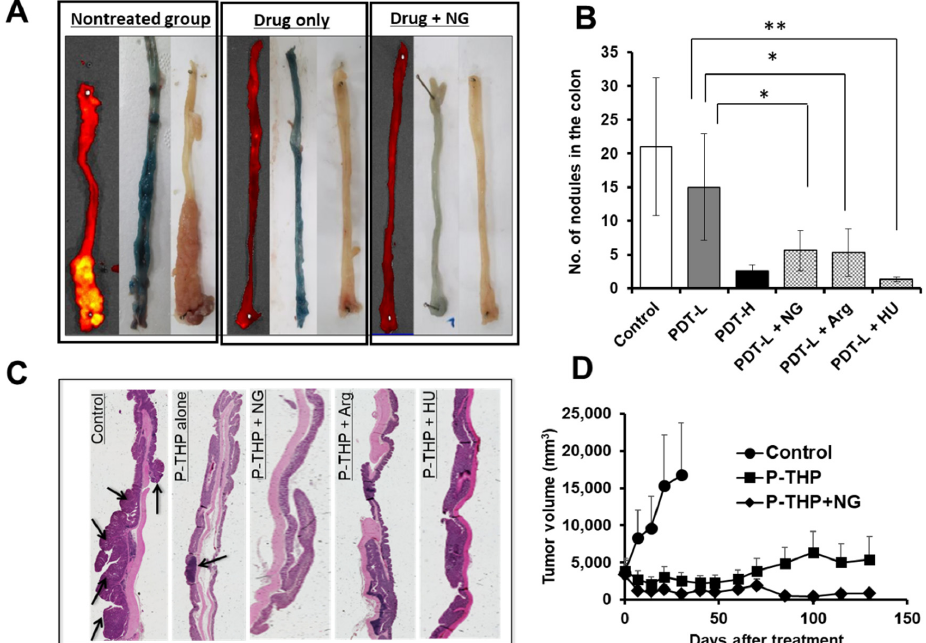
Figure 4. Improvements in therapeutic effects of nanomedicines by using NO donors in chemically induced tumors. Autochthonous colon tumor was developed by administering the chemical azoxymethane (AOM, 10 mg/kg, intraperitoneally) followed by 1 week of drinking 2% dextran sodium sulfate (DSS). At 8–10 weeks after AOM injection, tumor nodules that appeared in the colon were confirmed by examining 2 or 3 randomly killed mice. P-THP at 15 mg/kg iv was infused with NG, and tumor nodules in the colon were visualized by using bovine serum albumin conjugated with rhodamine or Evans blue after 30–40 days of P-THP treatment ( A ). Another nanomedicine, PZP, which was used with light irradiation (PDT) and EPR effect enhancers, produced a similarly improved therapeutic effect ( B ). Enhancement of the anti-cancer effect with NO donors in colon tumors was confirmed by means of macroscopic and microscopic histology ( C ). Arrows indicate tumor nodules in the colon. ( D ) Enhanced therapeutic effect of P-THP with an NO donor in an advanced breast tumor in the rat. Breast tumors were generated by using dimethylbenz[ a ]anthracene (DMBA, 10 mg/mouse, orally), and tumors appeared 12–14 weeks after DMBA administration. Data are expressed as means ± SD. n = 5, * p < 0.05, ** p < 0.01, For details please see Islam et al. [28].